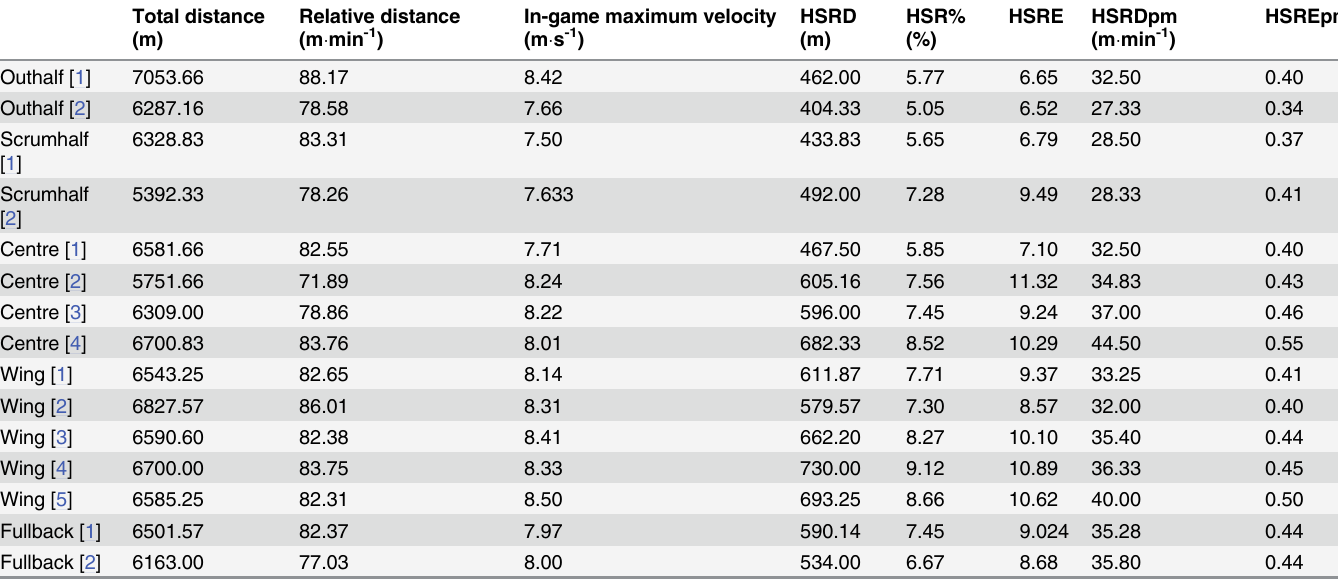
Table 8. Descriptive statistics on the IND HSR output of individual backs players. Total distance